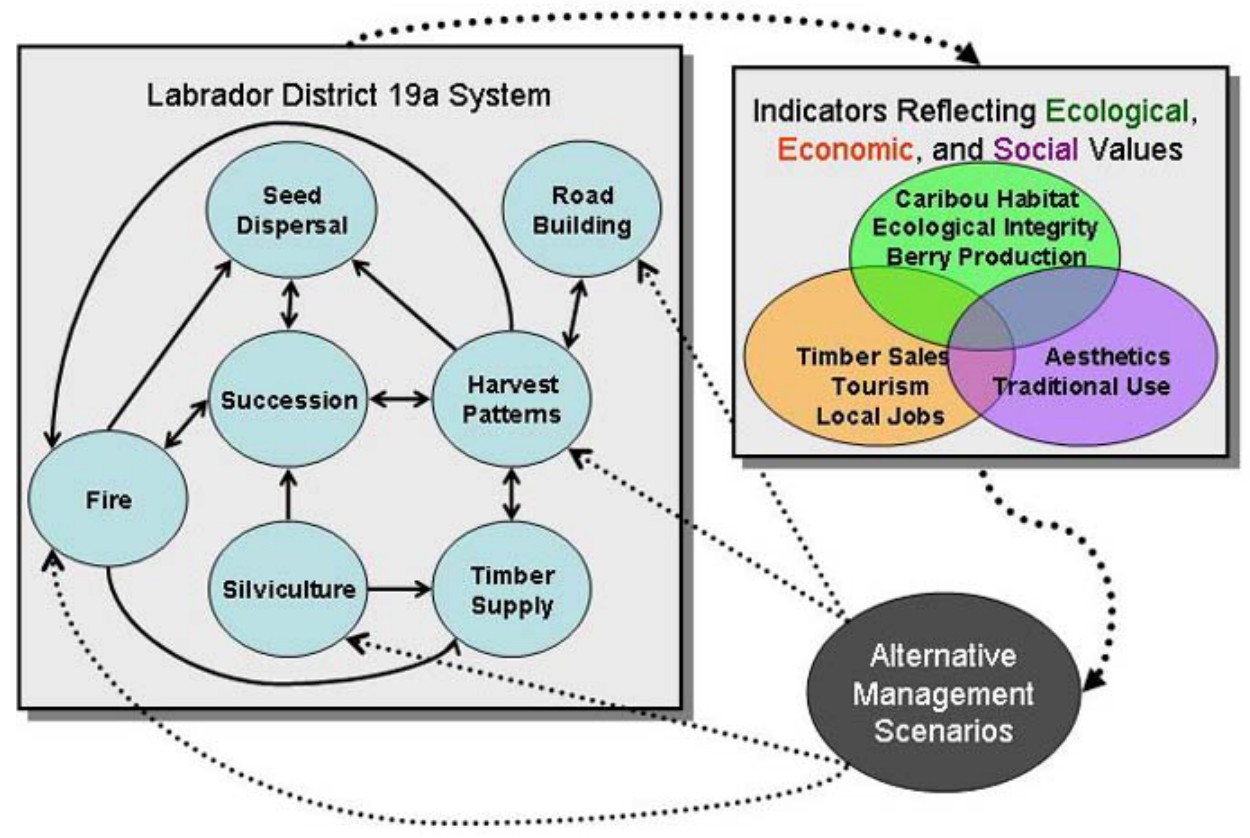
Fig. 4. The formal conceptual model for Labrador planning district 19a meta-model. Key processes and their interactions are simulated within the interactive model system, which outputs information to be translated into key indicators of sustainability reflecting different values. Alternative management scenarios act on the model system through the subset of the processes humans influence; the relative success of those scenarios is quantified by the